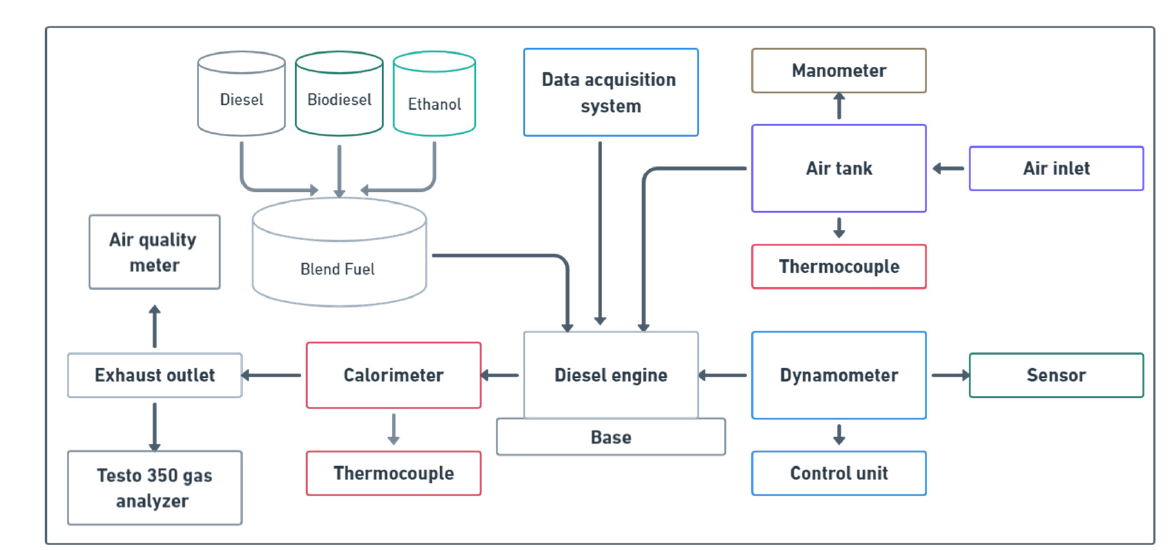
Figure 2. Schematic diagram of test engine and procedures.